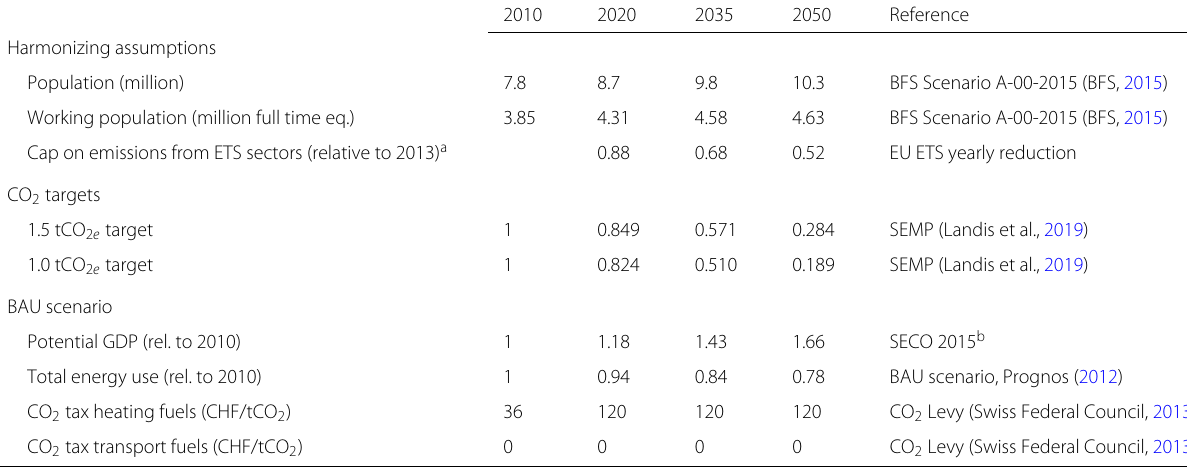
Table 2 Harmonizing assumptions and CO 2 targets